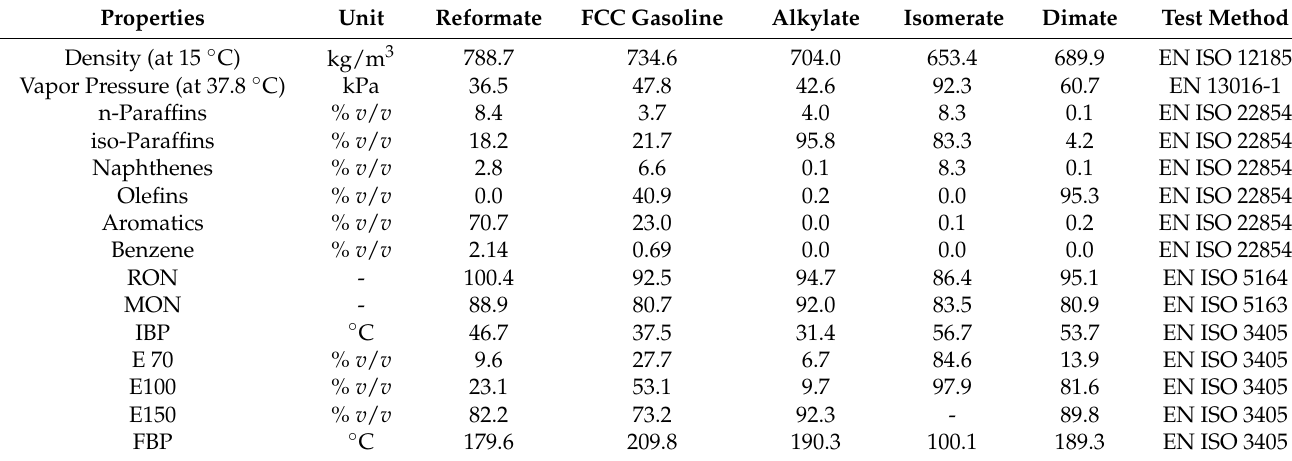
Table 1. Properties of the refinery fractions.